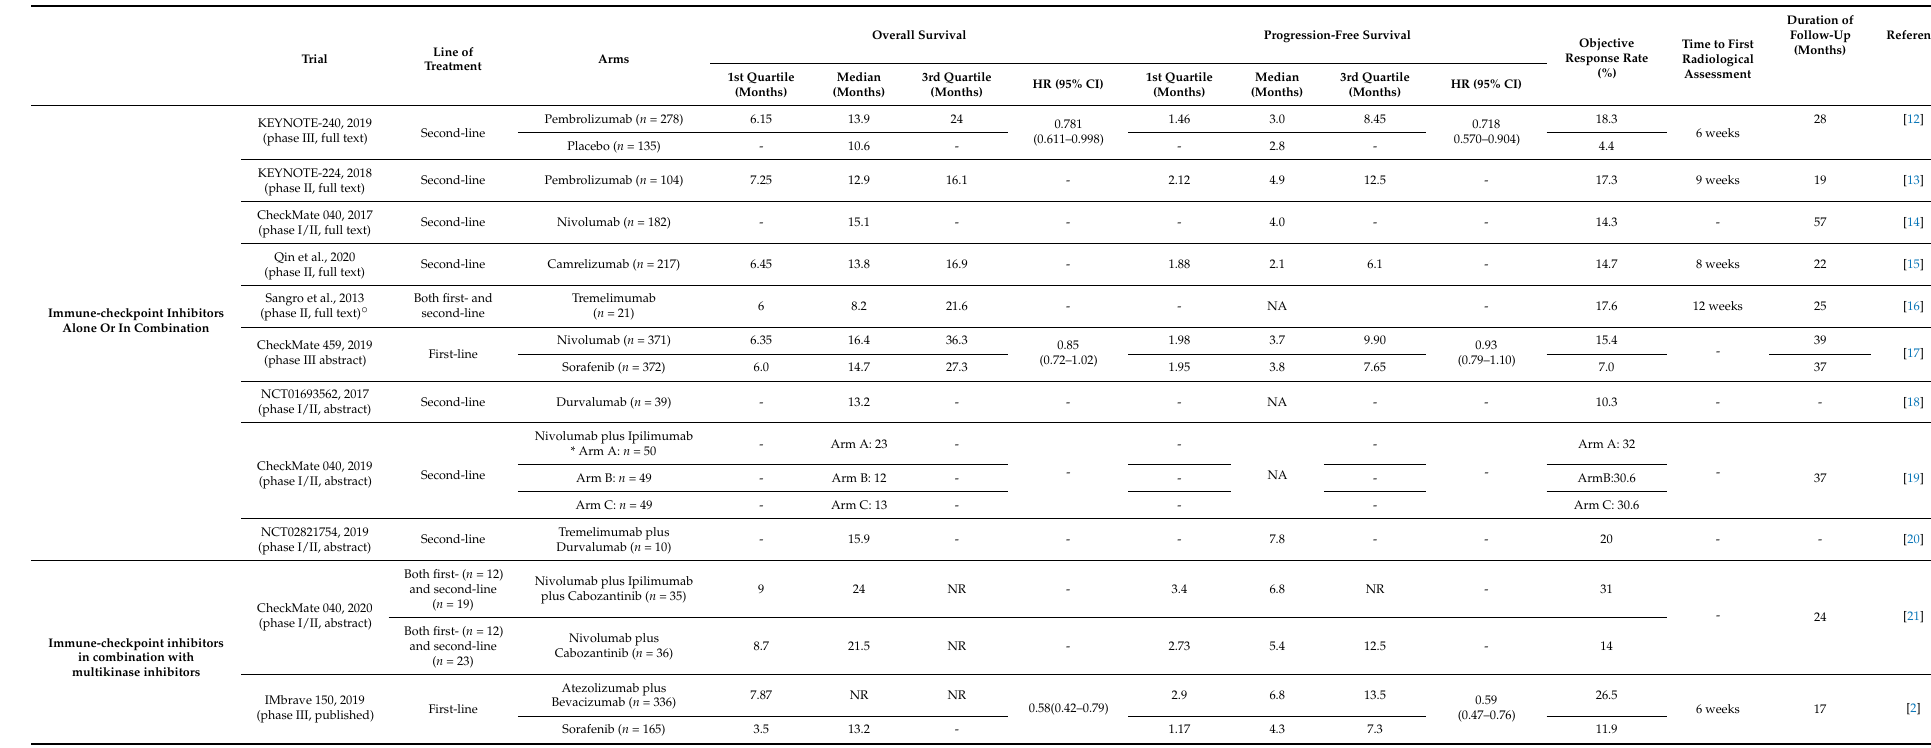
Table 1. Characteristics and clinical outcomes of ICI clinical trials for the treatment of advanced hepatocellular carcinoma (HCC) included in the study.